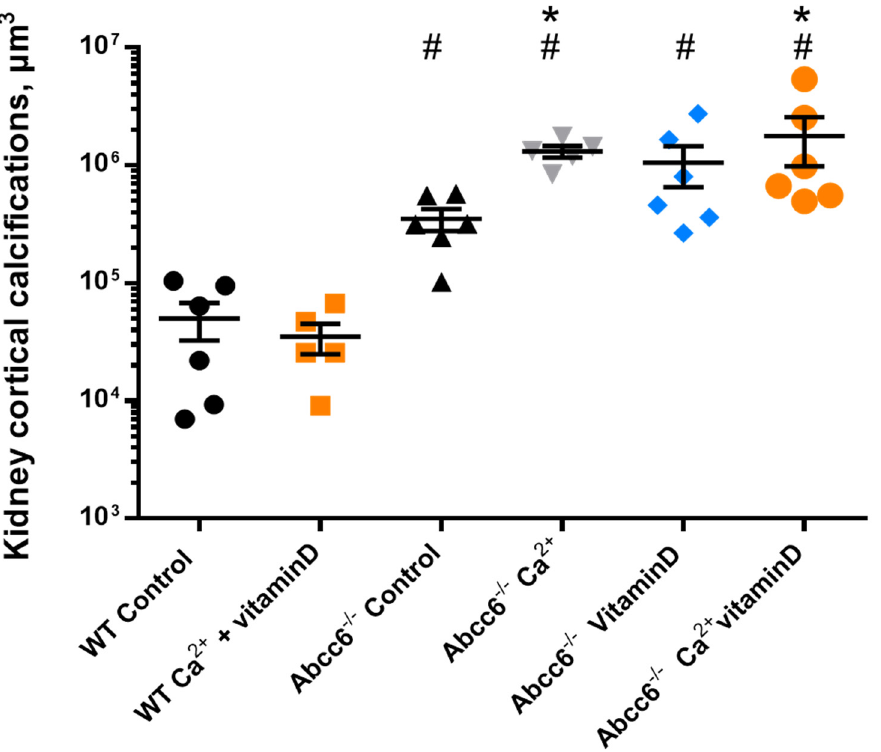
Figure 5. Volume of kidney vascular calcification quantified by CT-scan in WT and Abcc6 − / − mice from all groups. * p < 0.05 vs. Abcc6 − / − control (untreated) mice. # p < 0.05 vs. WT control or WT Ca2 ++ vitamin D mice.